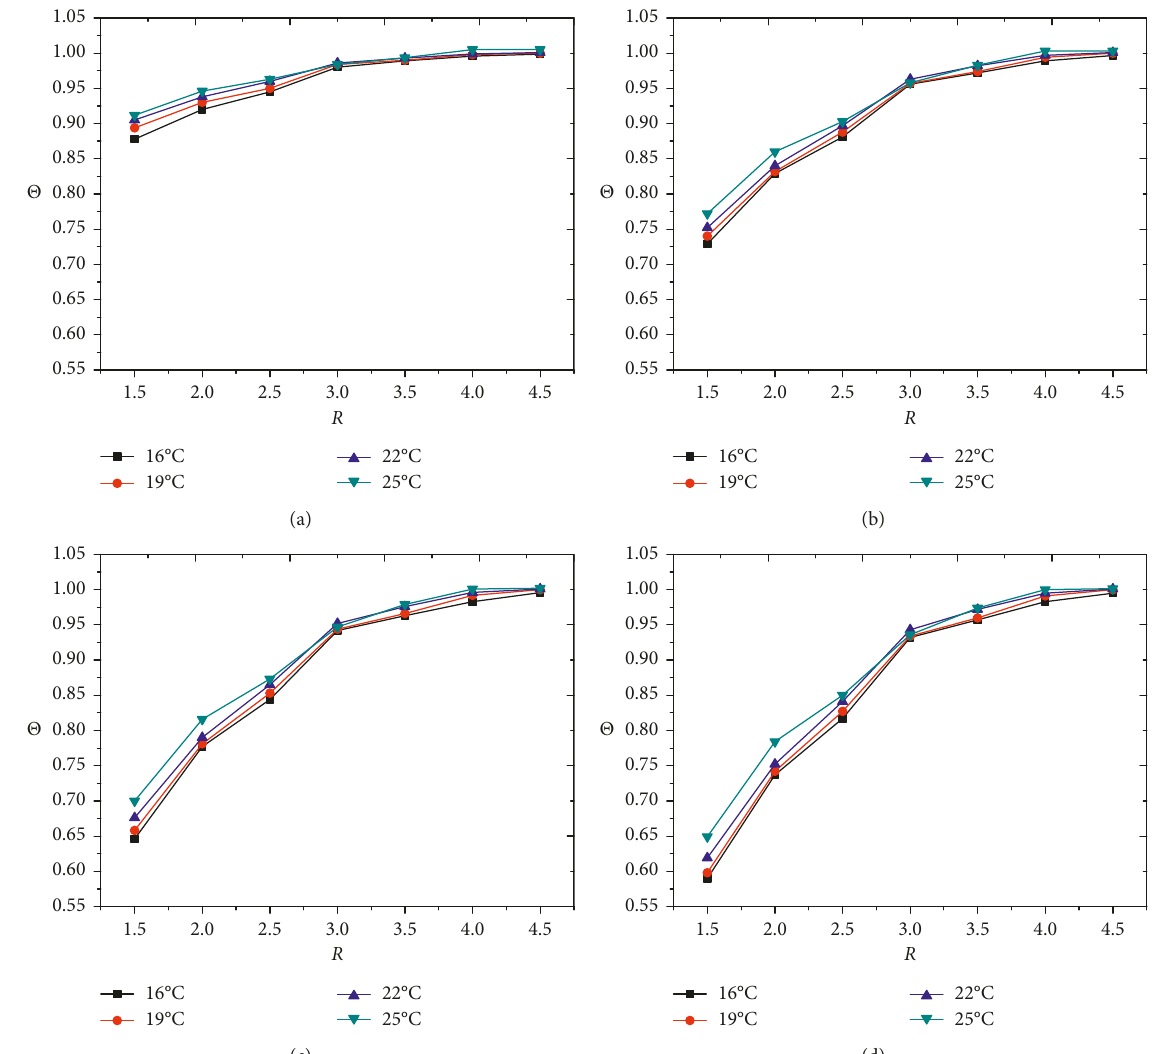
Figure 8: Effect of t